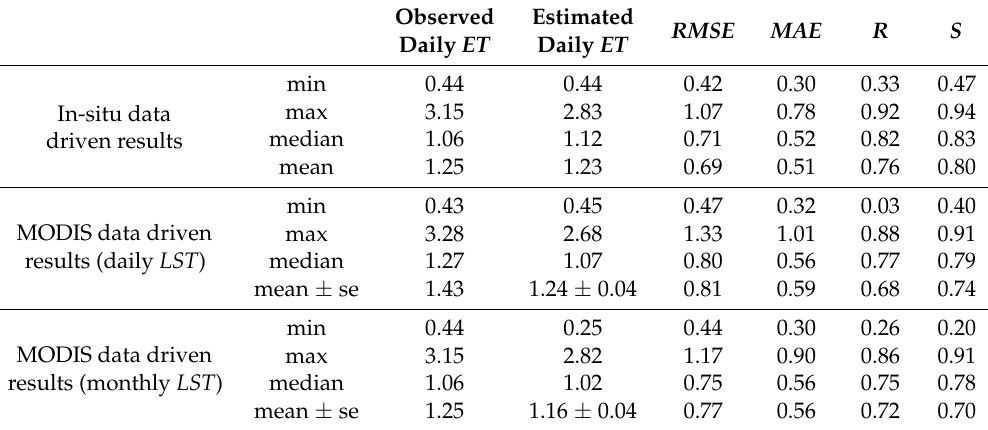
Table 4. Summary of results and statistics at the AmeriFlux sites used in this study, where the min, max, median and mean values correspond to the mean ET (mm day − 1 ), RMSE (mm day − 1 ), MAE (mm day − 1 ), R and S , based on daily ET estimates at each individual site using site measurements or MODIS datasets at a spatial resolution of 0.05 degrees; for MODIS derived values, mean ET LST is the average of the daily means ± the average of the standard error (se) of the daily means (discussed later) from each site. A supplementary table is provided showing the sites details. Observed Estimated Daily ET Daily ET